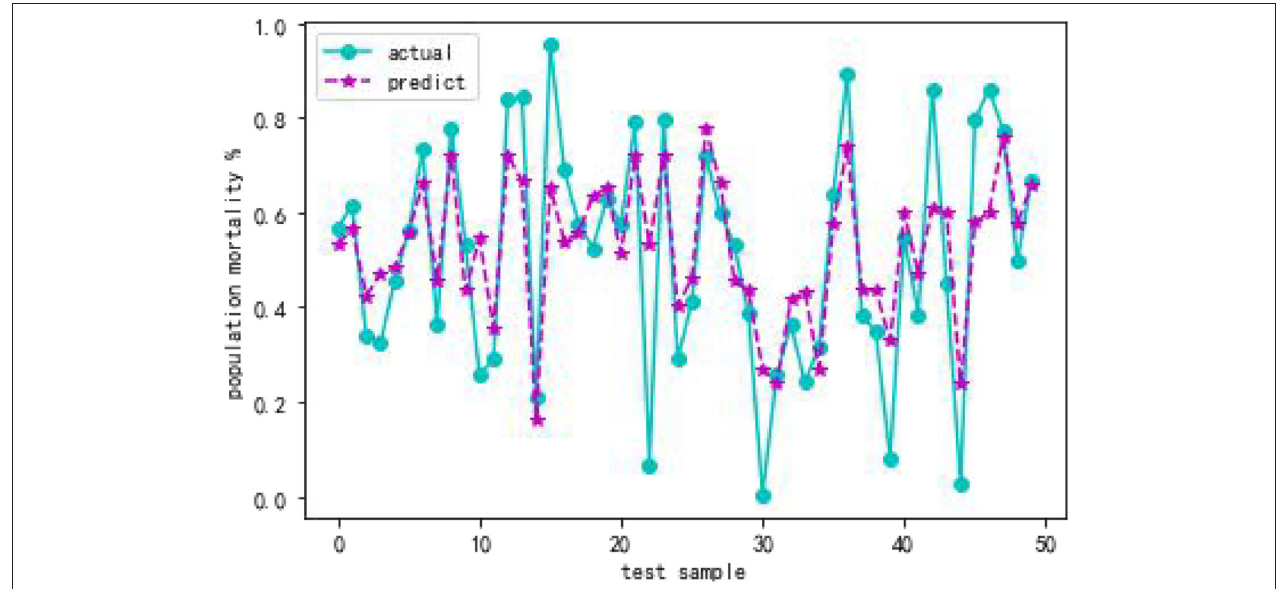
FIGURE 3 | Comparison of XGBoost model predicted value and actual value.